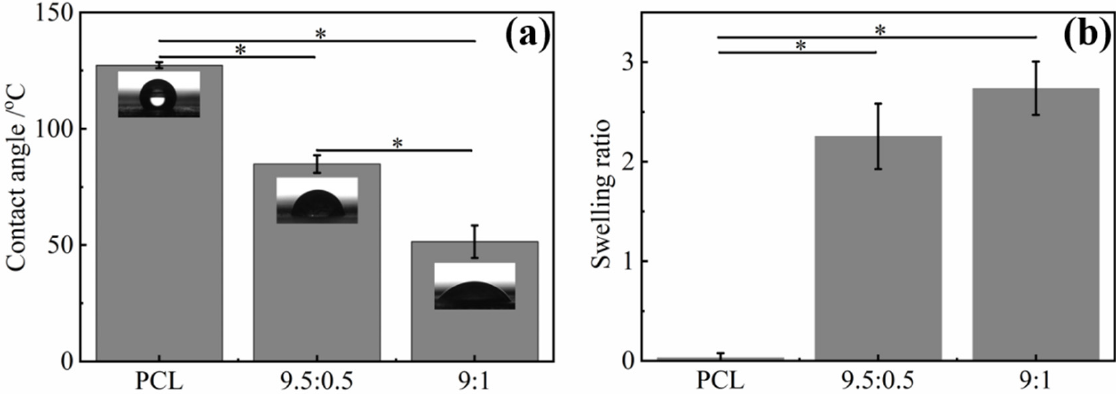
Figure 5. Water contact angle ( a ) and swelling ratio ( b ) of electrospun nanofiber scaffolds spun from PCL and from solutions with different PCL/TA weight ratios (9.5:0.5 and 9:1) (* p < 0.05).